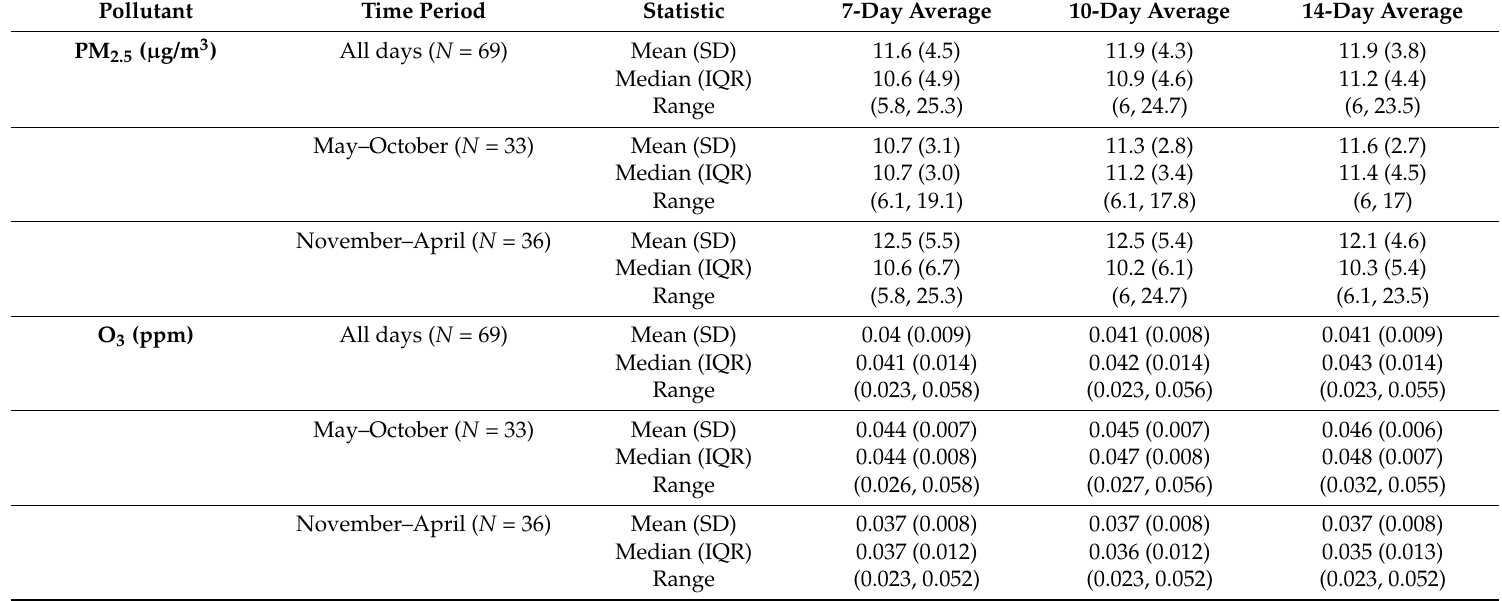
Table 2. PM 2.5 and O 3 levels during the study